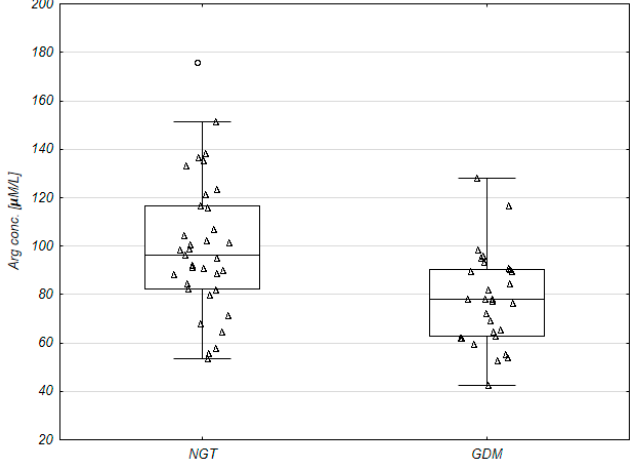
Figure 1. Important features selected by volcano plot with fold change threshold (x) 1.1 and U Mann–Whitney’s test threshold (y) 0.05. The red circle represents features above the threshold. Both fold changes and p values are log transformed.